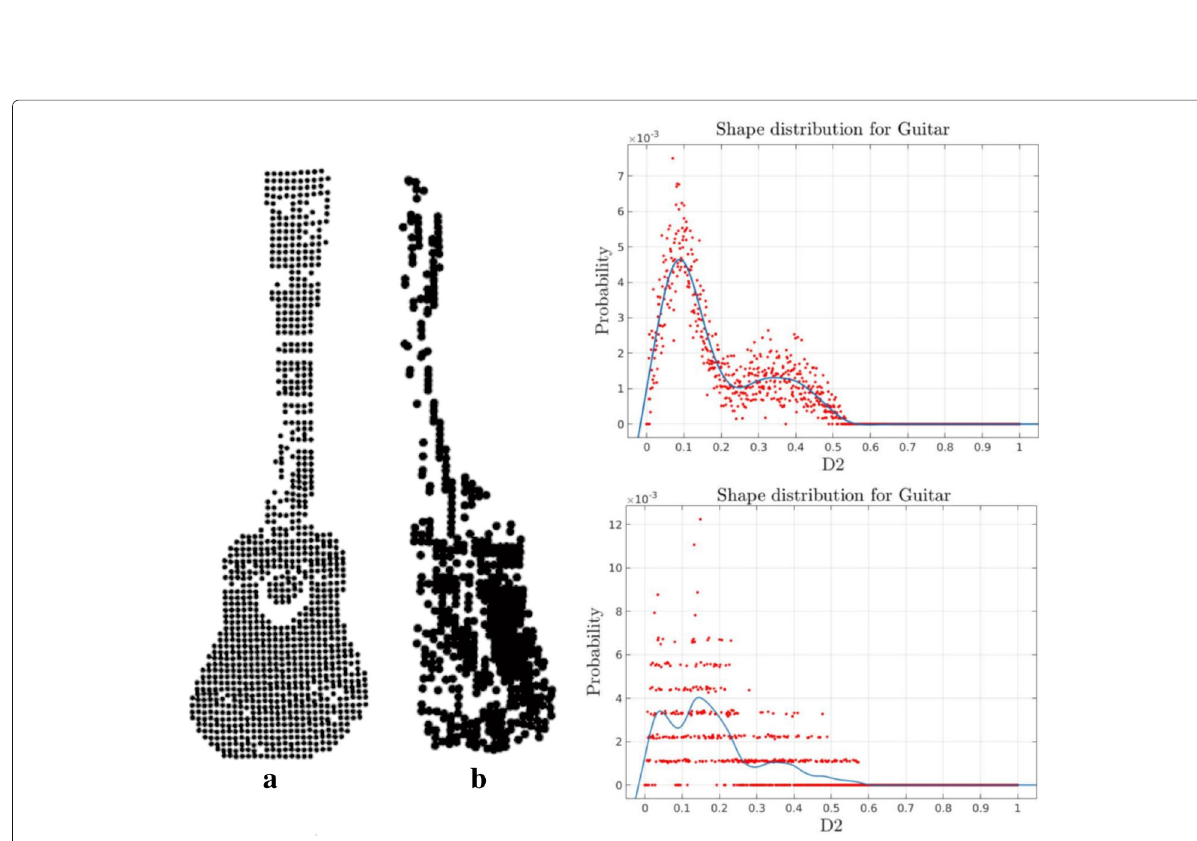
Fig. 7 D2 shape distribution for two different guitar poses (captured using ToF camera). Left : b is rotated 30° from a . Right : top represents a , bottom for b . The redpoints are actual D2 distribution of the views, and fitted with smoothing splines and polynomial curves ( bluecurves ) of degree 9 instead of piecewise linear functions used by Osada et al.